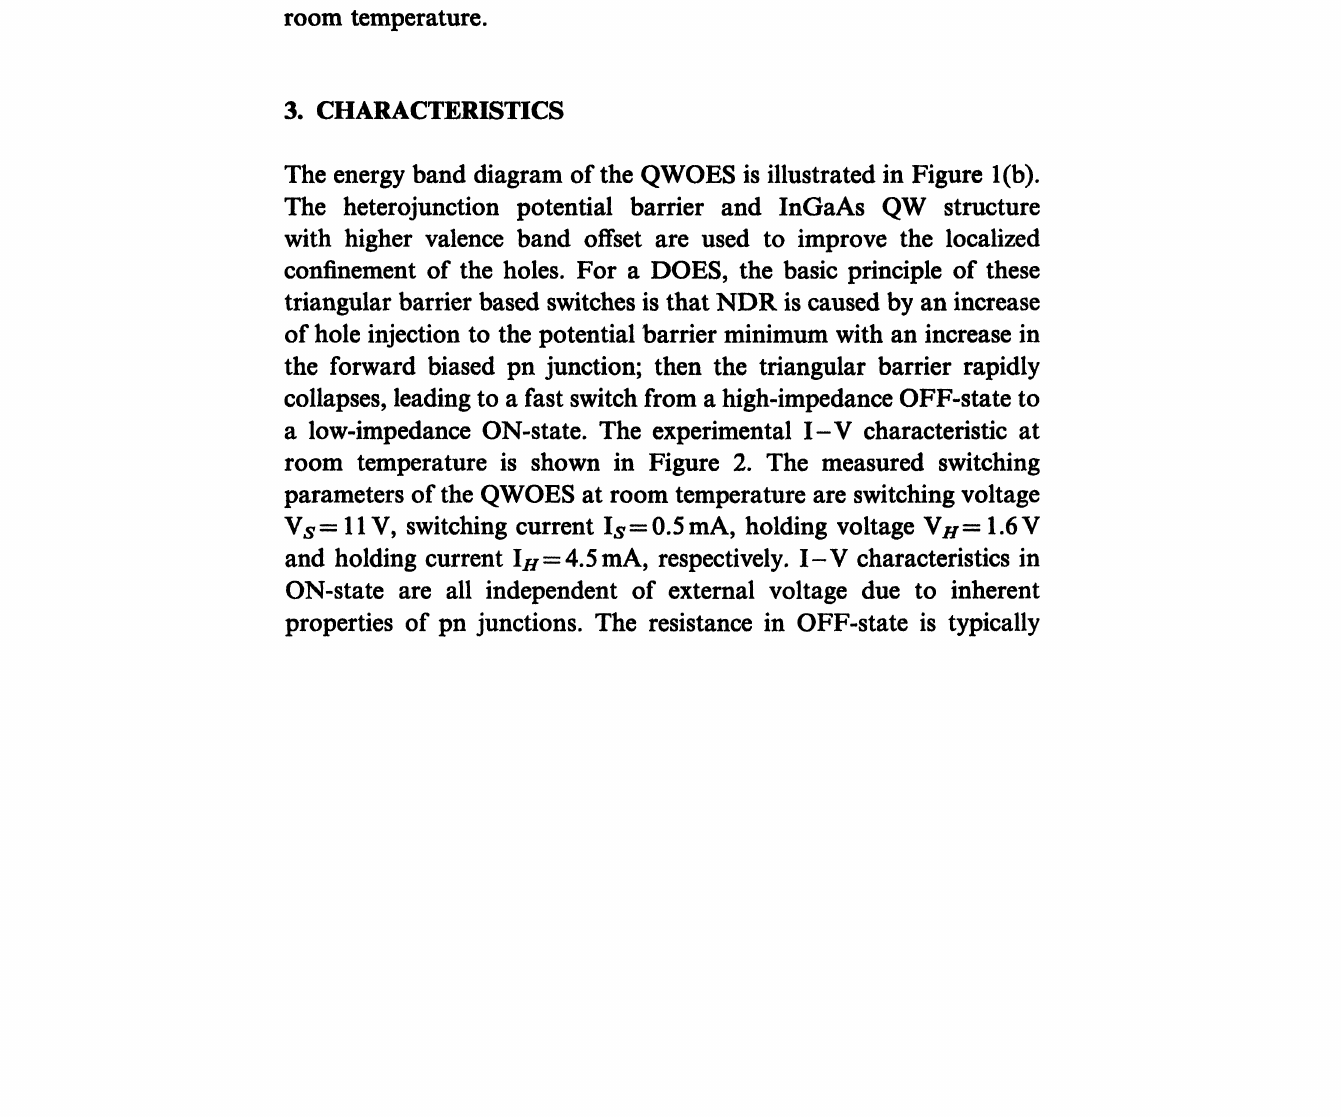
FIGURE (a) Schematic cross section ofthe QWOES (b) Energy band diagram of the QWOES at equilibrium. on the n-side and the wafer was then alloyed. The area of the laser bar was 150 Im 350 pm after cleaving. Electrical current-voltage (I-V) harateristics were measured by a Tektronix 370A urve tracer at room